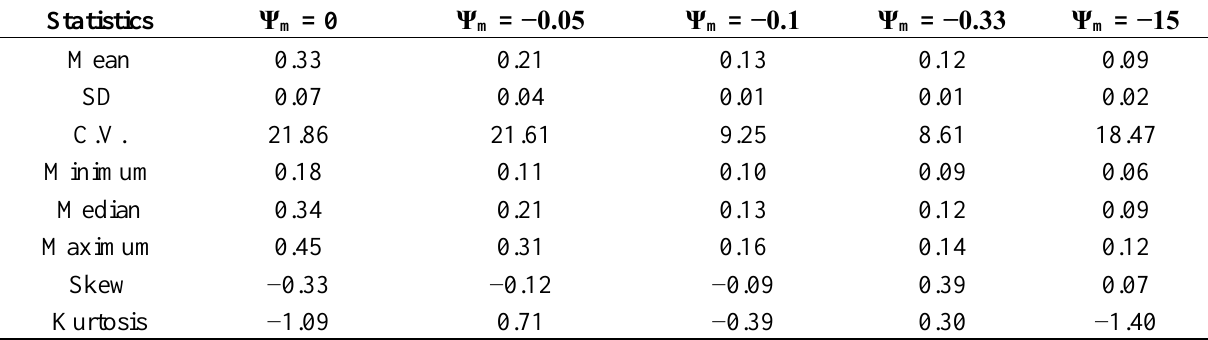
Table 1. Descriptive statistics for soil moisture (θ, m 3 m −3 ) at five different matric potentials.